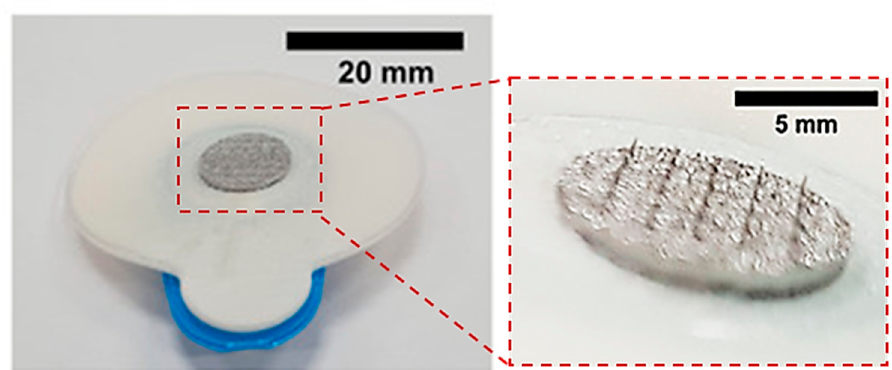
Figure 6. 3D printed 5 × 5 MN electrodes used for measurement of electrical muscle activity in humans. Reprinted with permission from Ref. [104] . 2020, Advanced Materials Technologies.